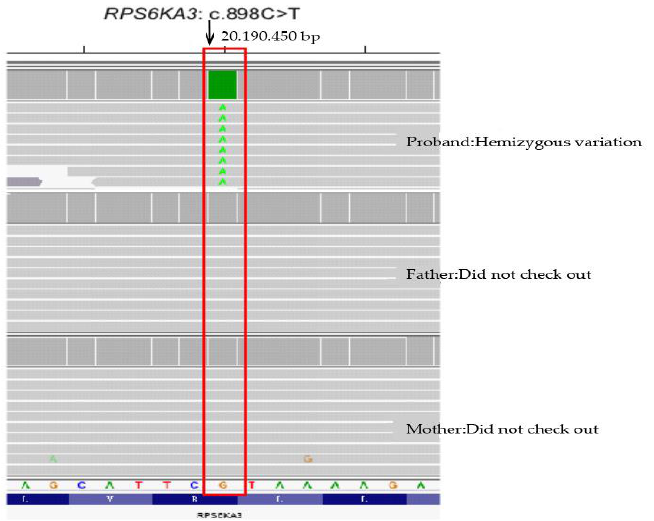
Figure 6. Integrative Genomics Viewer (IGV) diagram of second-generation sequencing (proband/father/mother) Note: RPS6KA3 gene is reverse encoding. Table 1. Proband sequencing results.